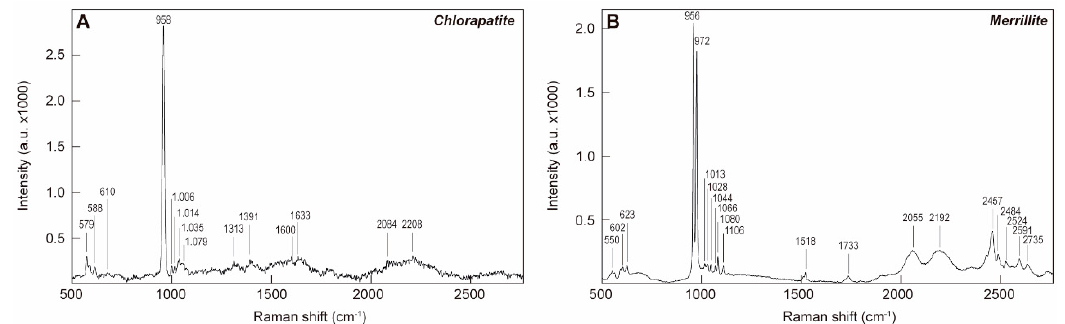
Figure 4. Raman spectra of two phosphate types: ( a ) Chlorapatite and ( b ) merrillite.